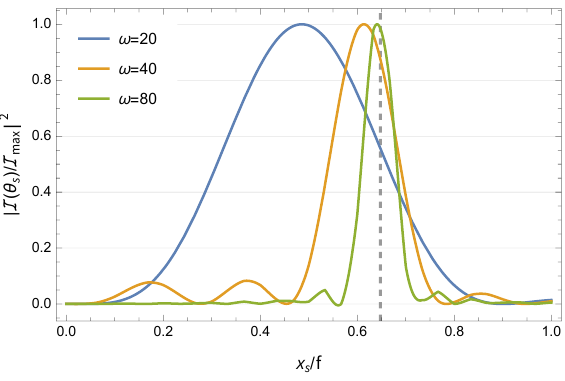
Figure 13 . The (cid:15) dependence of a cross-section view of the image for a vector-mode perturbation. We set r h = 0 . 3 , θ obs = 0 ◦ , ω = 80 , d = 0 . 5 , σ = 0 . 01 , and (cid:15) = 0 . 0 , 35 . 0 , 41 . 0 .